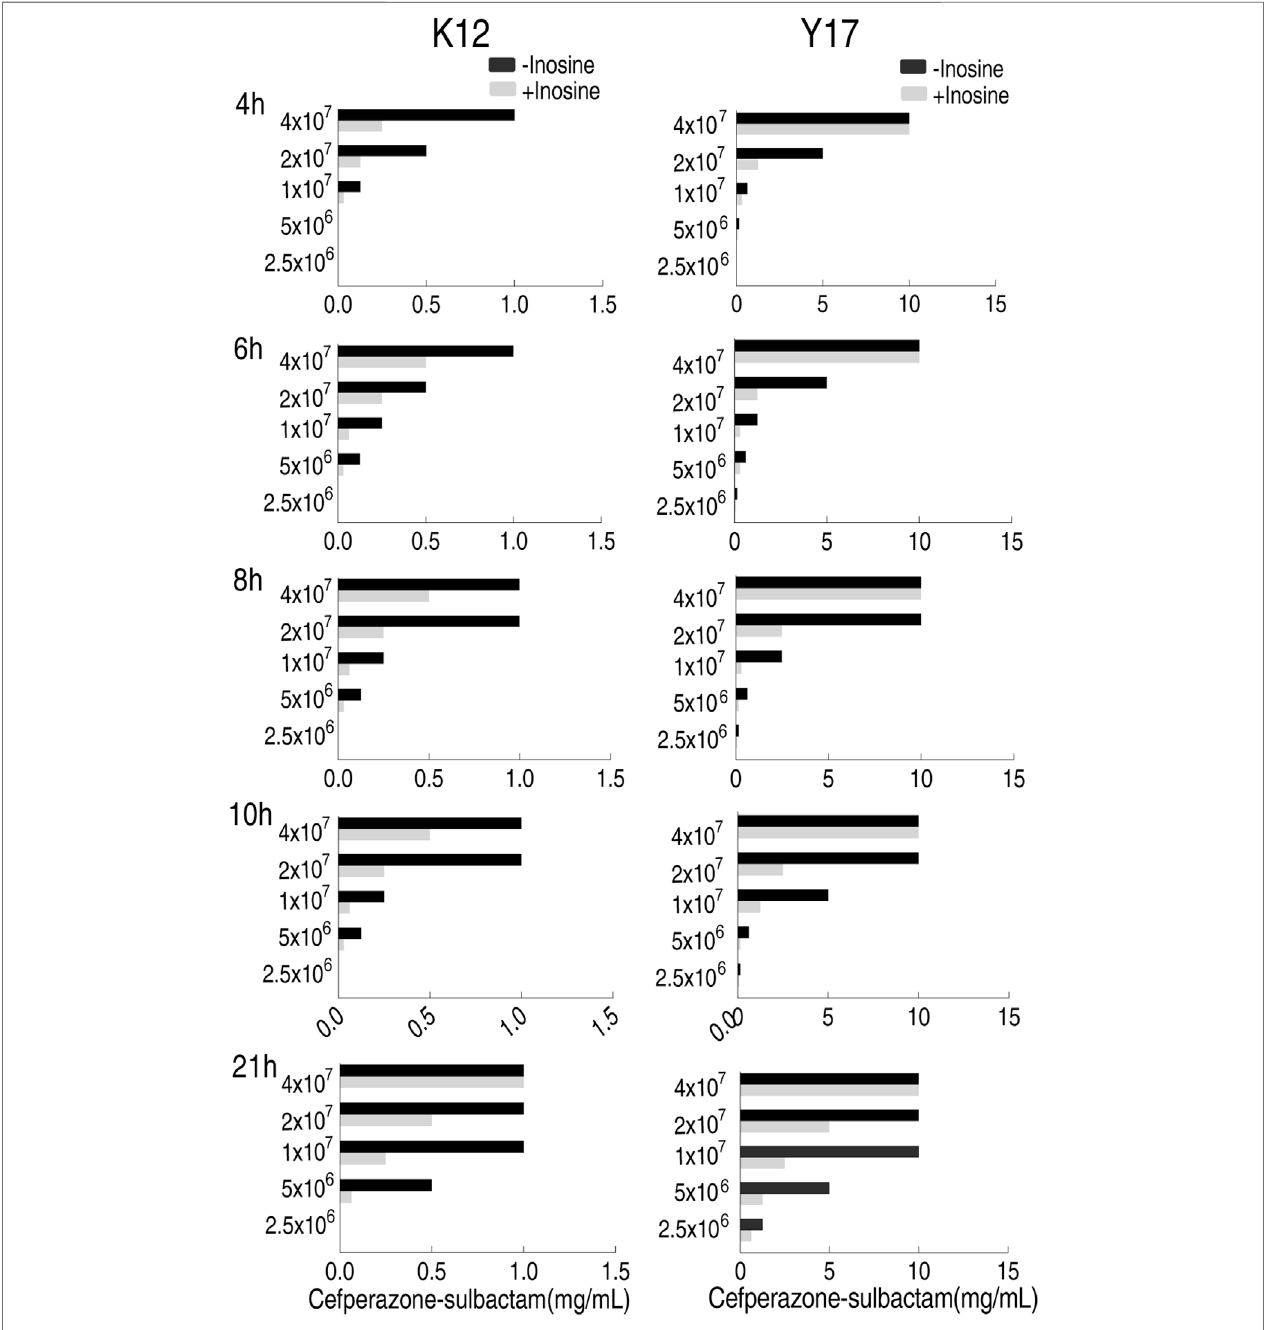
FIGURE 2 | MKC of K12 and Y17 in fi ve bacterial doses and fi ve incubation time by SCF.